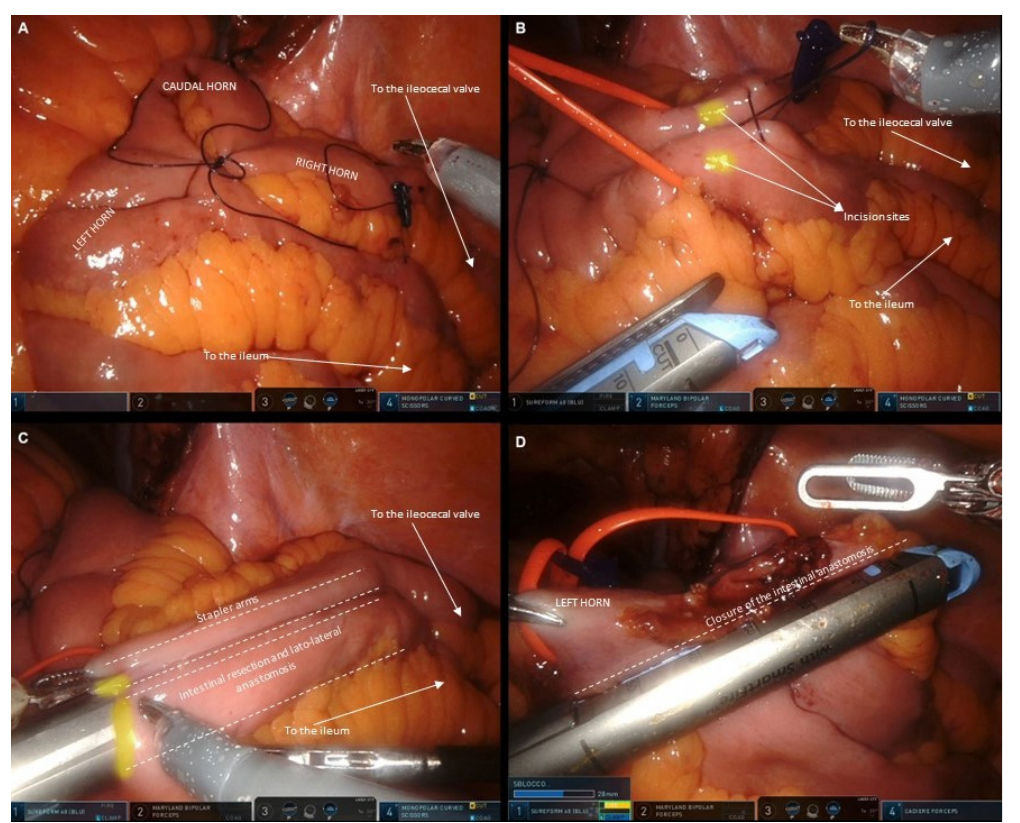
Figure 1. ( A ) Shaping the reservoir. ( B – D ) Intestinal